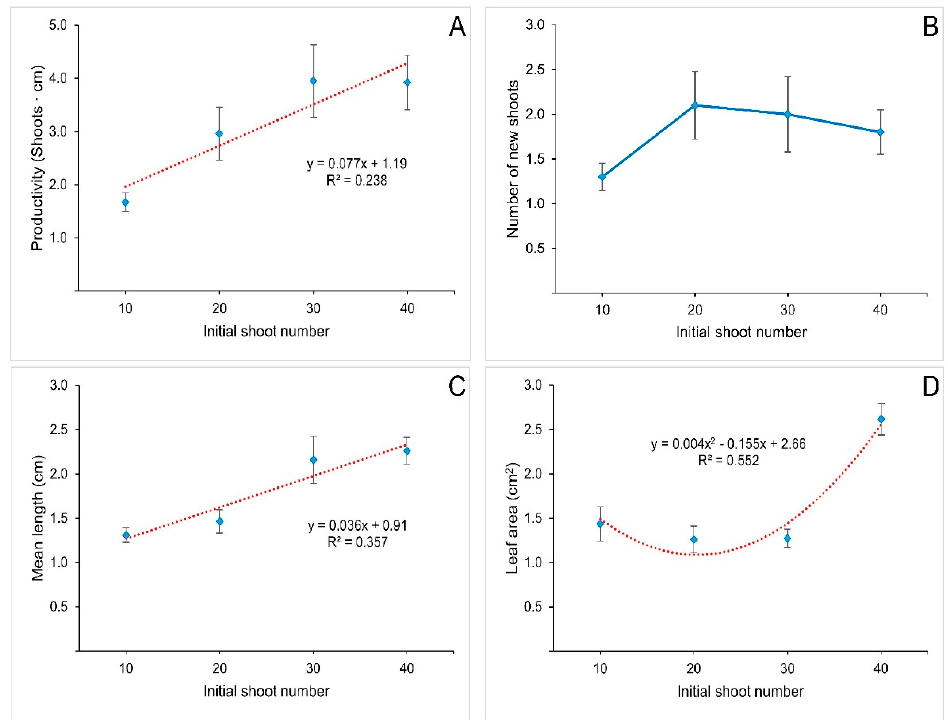
Figure 3. Effect of initial shoot density in TIS on productivity ( A ), number of new shoots ( B ), mean length ( C ) and leaf surface ( D ) of ‘Canino’ shoots. Discontinuous line represents the results of trend analysis. Bars are the standard error of mean values.